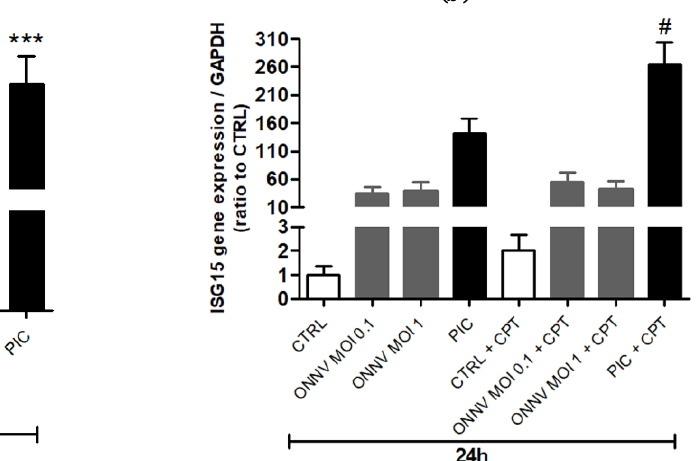
Figure 2. CPT enhances ISG15 gene expression in PIC-stimulated HSF. ISG15 mRNA levels from HSF treated with ( a ) ONNV (MOI 0.1 and 1) and PIC (1 µ g/mL), and ( b ) co-treated with CPT-11 (15 µ M), for 6 and 24 h, were evaluated by RT-qPCR. Results are expressed as mean ± SEM of four independent experiments. Statistical significance is indicated as follows: p -value < 0.05 (*), p -value < 0.01 (**), p -value < 0.001 (***) compared to control at the corresponding time of treatment; p -value < 0.05 (#) compared to the corresponding treatment without CPT-11.